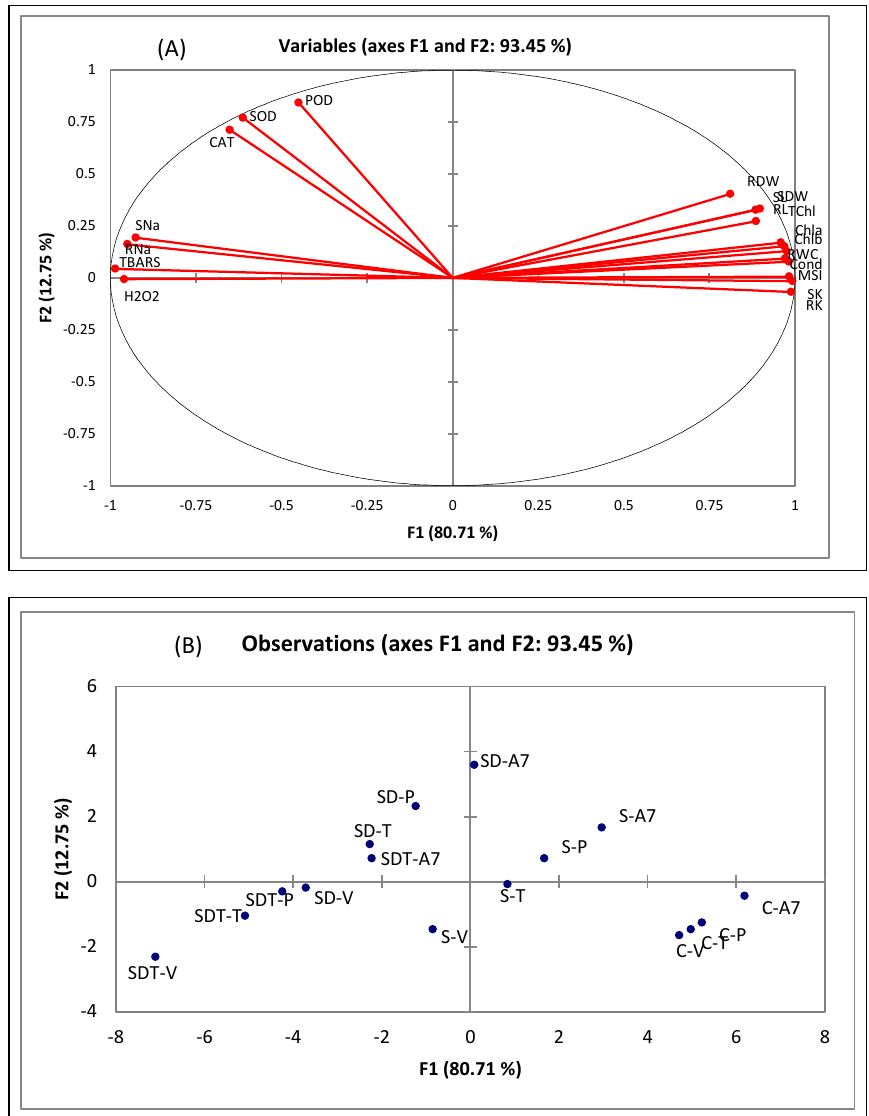
Figure 6. Principal component analysis of ( A ) different response variables and ( B ) different treatments and genotypes of quinoa grown under salinity, drought, and heat stress.